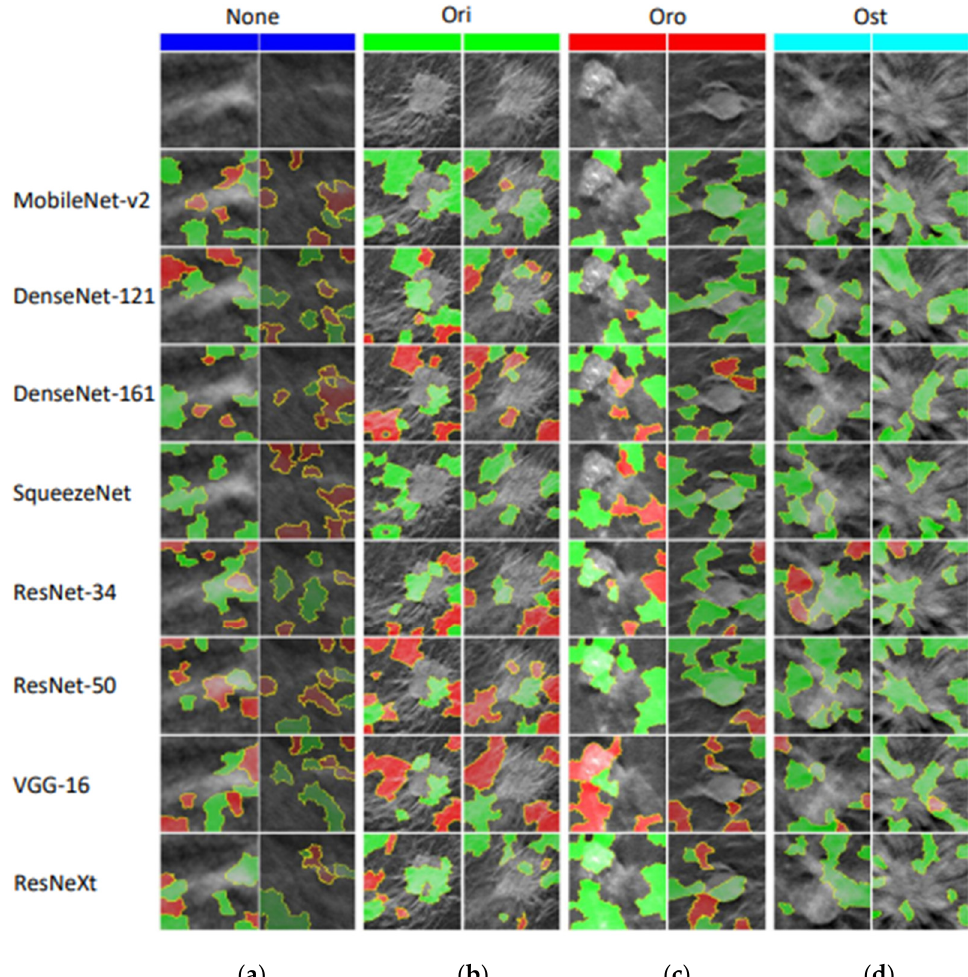
Figure A2. LIME Region of Interest (ROI) images for ( a ) No lesions (None); ( b ) Irregular opacity (Ori); ( c ) Regular opacity (Oro); and ( d ) Stellar opacity (Ost). (b) Class Activation Mapping (CAM): The Figure A3 shows the GRAD-CAM meth-